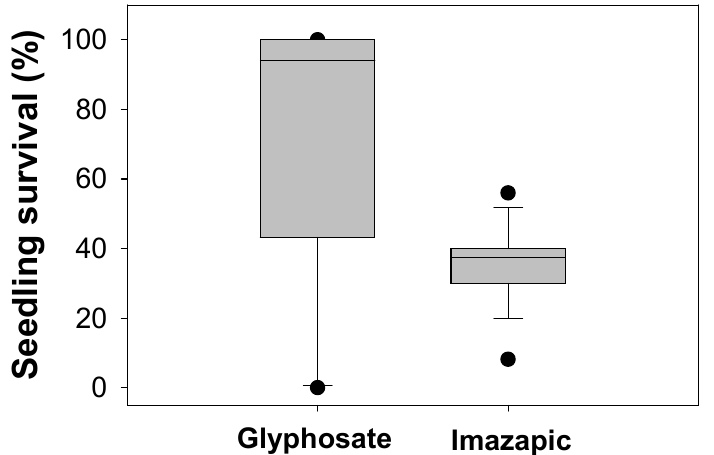
Figure 2. Seedling survival (%) in 40 populations of Chloris virgata in response to the field rate of glyphosate (741 g a.e. ha − 1 ) and imazapic (96 g a.i. ha − 1 ). In this box plot, the bottom and top lines indicate the 25th and 75th percentiles of the distribution, respectively; lines within the box indicate the median; whiskers below and above the box indicate the 10th and 90th percentiles; and circles indicate the 5th and 95th percentile.